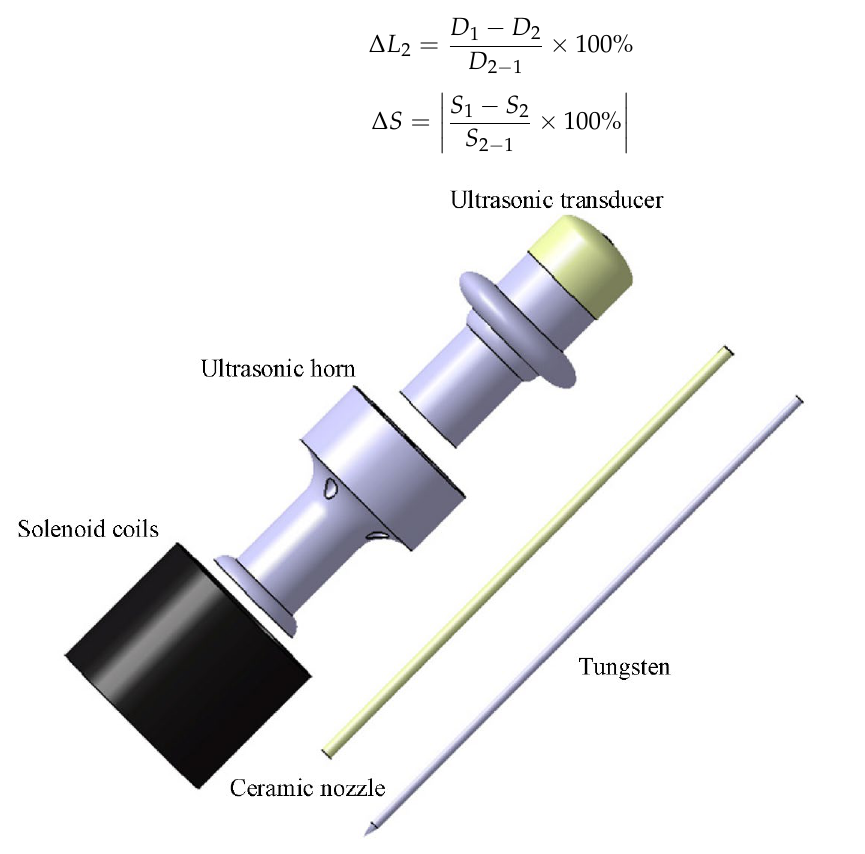
Figure 2. The exploded diagram of the composite welding torch. Arc measurement parameters are shown in Figure 3: the dark region and luminous region are expressed in S 1 and S 2 , respectively, the diameter of the dark region and lumi- nous region at the root of the arc are d 1 and d 2 , the diameters of the dark region and lumi- nous region at the maximum diameter were D 1 and D 2 . Using the first set of data as a baseline, the arc variation degrees at different locations were expressed as Δ L 1 (Degree of arc root diameter change), Δ L 2 (Degree of maximum diameter change), and Δ S (Degree of area change), as shown in Equations (1)–(3):